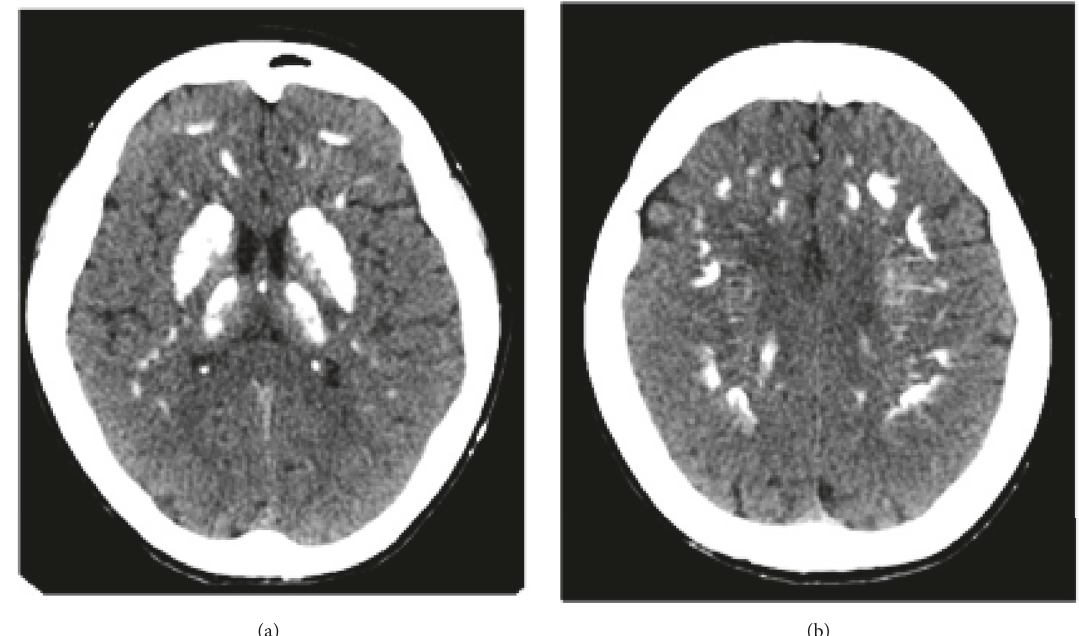
Figure 1: Basal ganglia (a) and subcortical (b) calcifications (CT